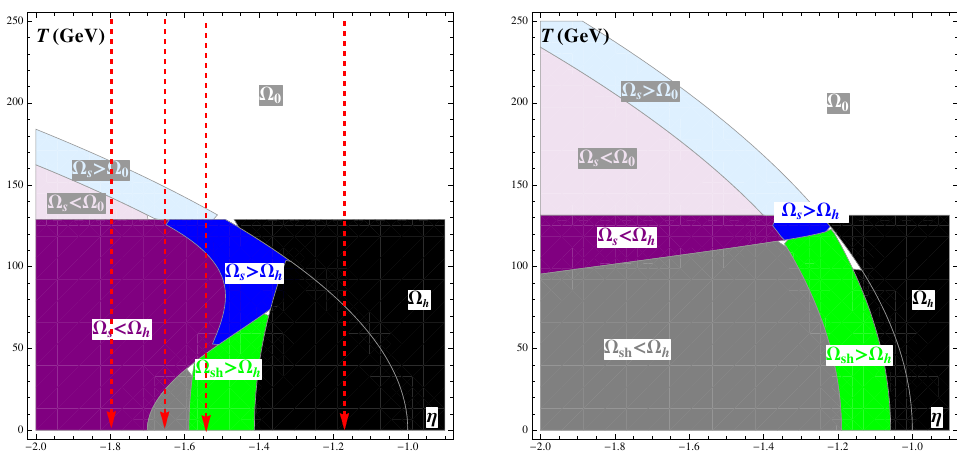
Figure 4 . Vacuum structure evolution under the high temperature approximation ( (cid:17) < 0 case). (Left panel): (cid:21) sh = 0 : 27, (cid:21) s = 1 and m s = 95 GeV; (Right panel): (cid:21) sh = 0 : 05 and (cid:21) s = 1 and m s = 160 GeV. They are corresponding to (cid:12)gure 2, but m s is (cid:12)xed here now. Dashed arrows indicate the evolutions of minima structure thus possible PT patters, from left to right: 1) (cid:10) 0 ! (cid:10) s ; 2) (cid:10) 0 ! (cid:10) s ! (cid:10) sh ; 3) (cid:10) 0 ! (cid:10) h ! (cid:10) s ! (cid:10) sh ; 4) (cid:10) 0 ! (cid:10) h . But we keep in mind that higher